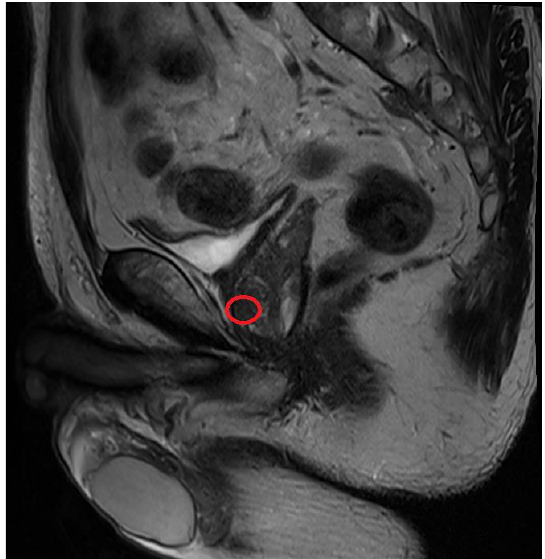
Figure 2. Suspicious lesion on the sagittal plane of T2-weighted image. The lesion was located at the apex of the prostate (red circle).